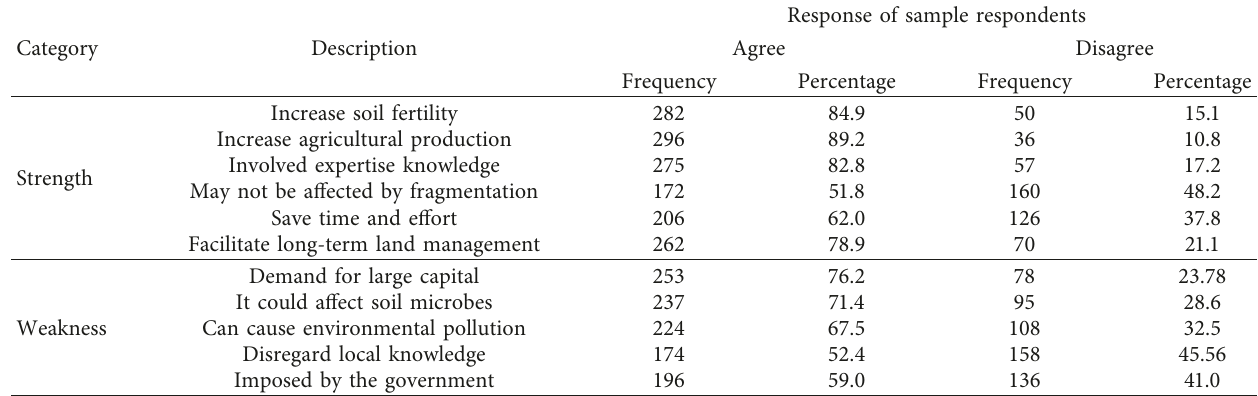
Table 6: The role of modern soil and water conservation technologies.